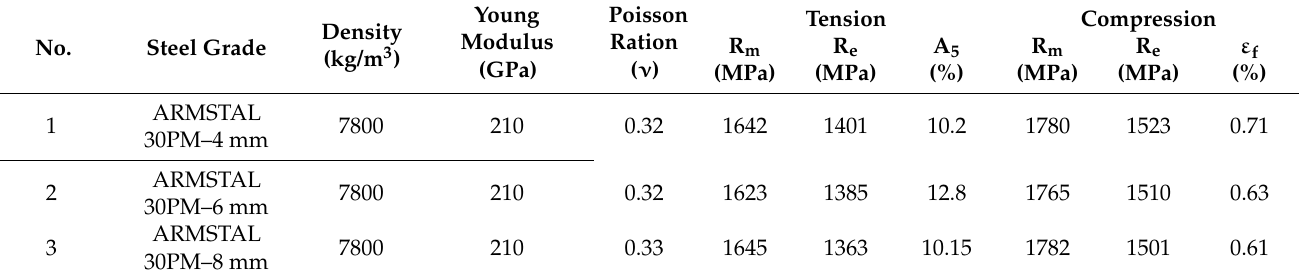
Table 5. Values of mechanical parameters of the ARMSTAL 30PM determined during the tests.